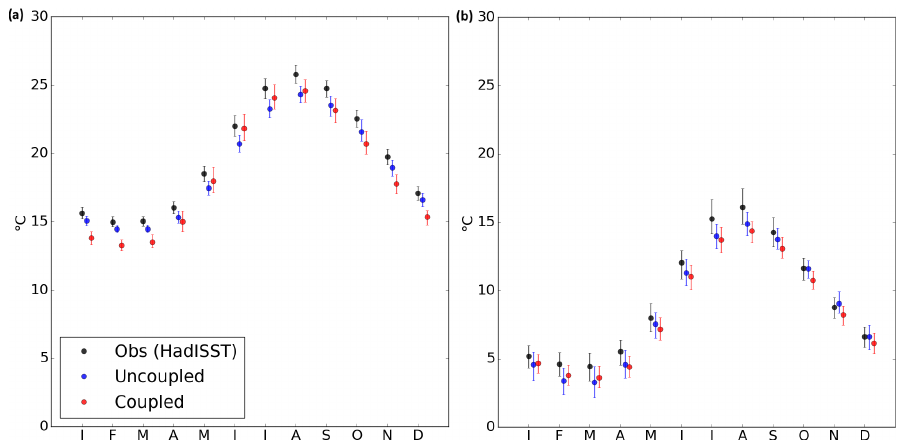
Figure 5. Annual cycle during the 20th century of the spatially averaged SST values in the marginal seas: (a) Mediterranean Sea; (b) Baltic and North Sea. Dots represent the mean monthly value and intervals show the 10th and 90th percentiles.